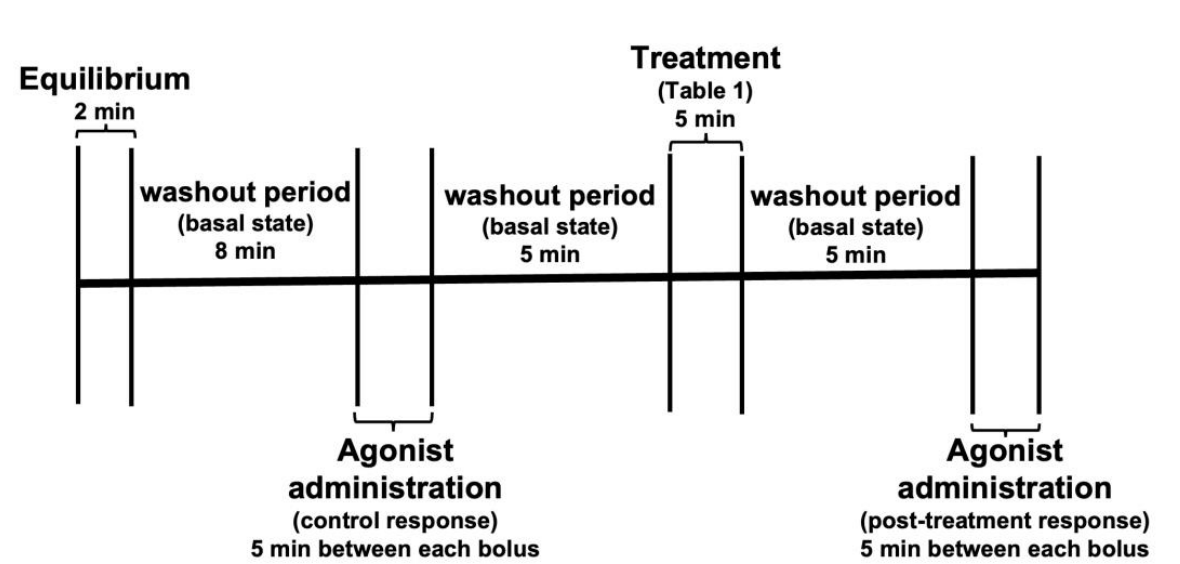
Figure 1. A representative scheme of the experimental flow used to assess the effect of the treatments on the cardiac response to agonists. Once the heart was attached to a non-recirculating retrograde perfusion system, a 10 min-period was given for stabilization (basal state) prior to the administration of Ang II, Phe and aCh to register the effects of agonists on the heart (control response over the basal state of the heart). Treatment was administered for 5 min after a second stabilization period and then extensively washed out to eliminate the non-adhered cells/structures. Then, a second administration of the agonists was performed to determine the effect of the treatment on the cardiac response (response post-treatment). For the initial experiment with C. albicans WT, 10 mM mannose was administered to the heart, followed by a third administration of the agonists to record the effect exerted by this sugar on reverting the treatment effect on cardiac responses (not shown).